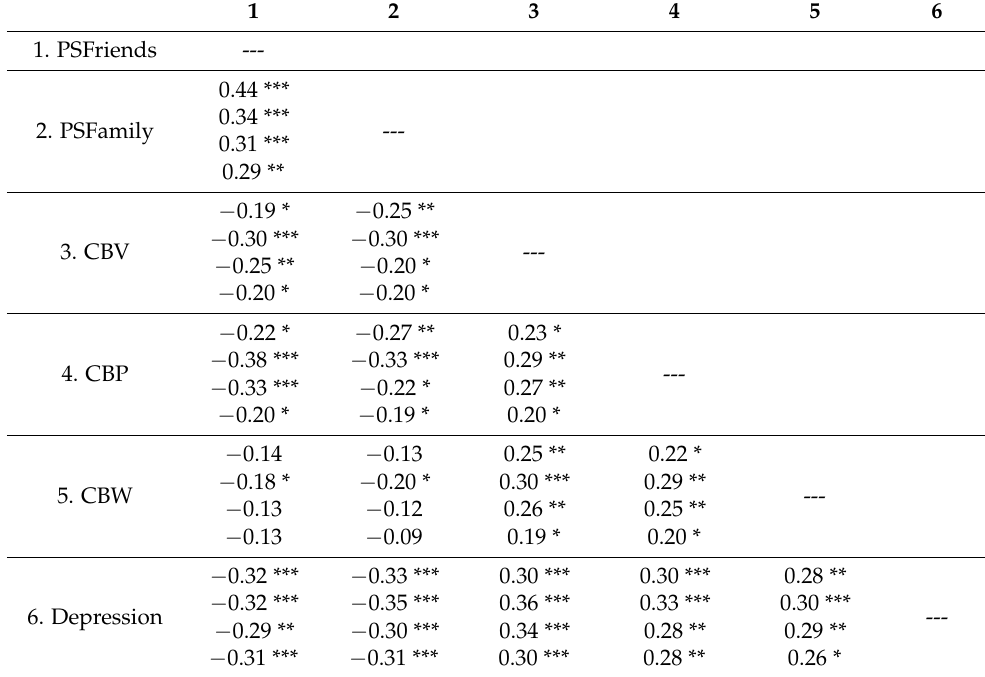
Table 1. Correlations among all